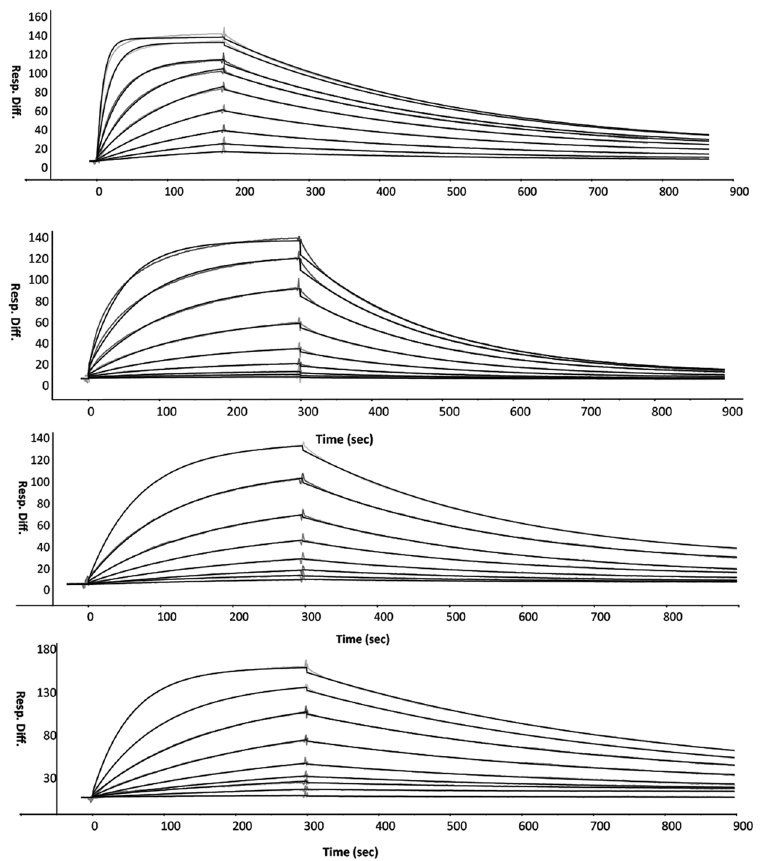
Figure 2. Binding kinetics for the interactions of Fabs ID7 and ID5 with the WT and mutant IDH1. ( a ) Interaction between ID7 and WT IDH1. ( b ) Interaction between ID7 and mutant IDH1. ( c ) Interaction between ID5 and WT IDH1. ( d ) Interaction between ID5 and mutant